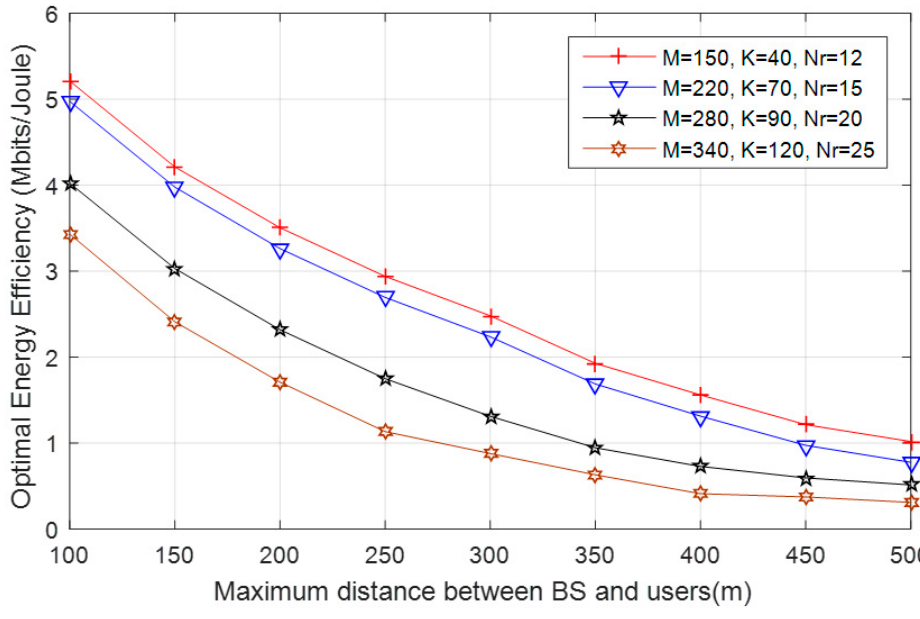
Figure 7. Optimal energy e ffi